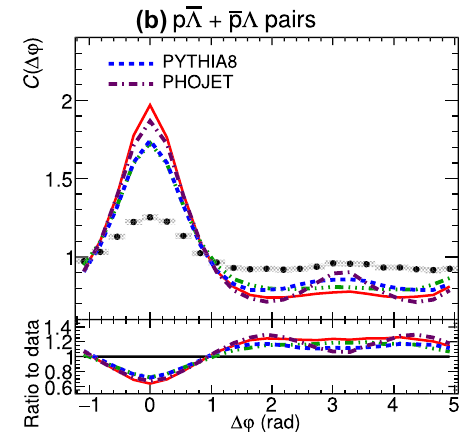
Perugia-0, PYTHIA6 Perugia-2011, PYTHIA8 Monash, PHOJET) at √ s = 7 TeV. Clear anti-correlation is observed for all baryon pairs. Statistical ( bars ) and systematic ( boxes ) uncertainties are